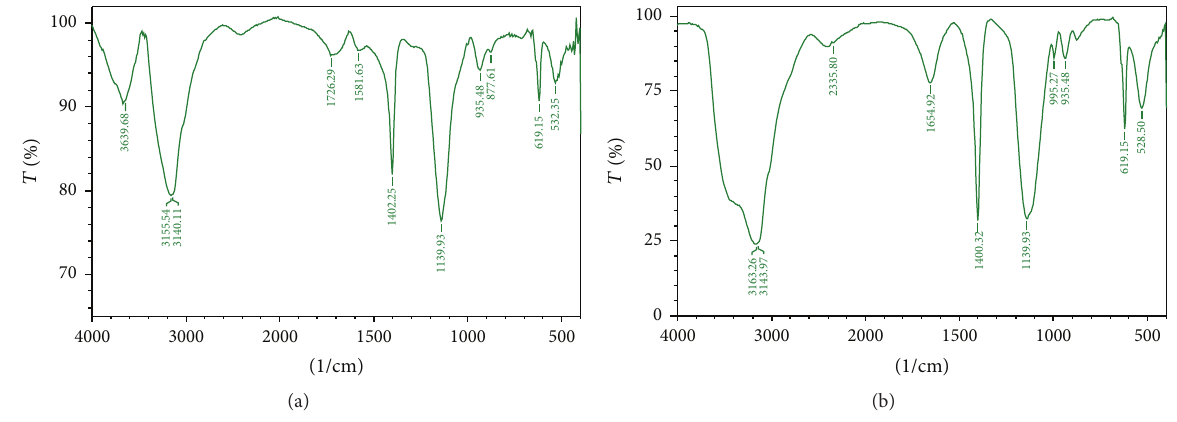
Figure 7: Aniline degradation spectra obtained before and after degradation. 1% aniline incubated with VITRSB1 strain and analysed in FTIR. (a) Aniline before degradation with VITRSB1 strain. (b) Aniline after degradation with VITRSB1